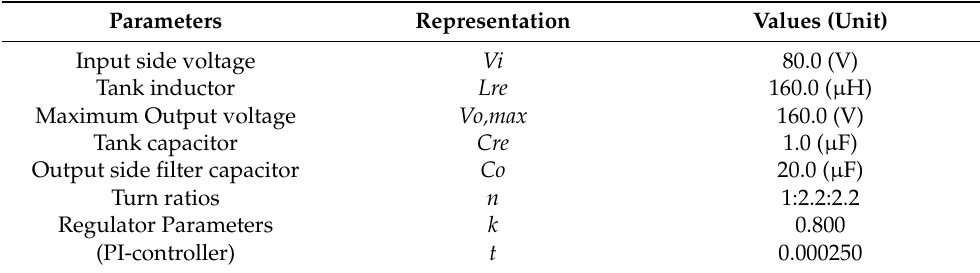
Table 3. Parameter of the Proposed Converter.